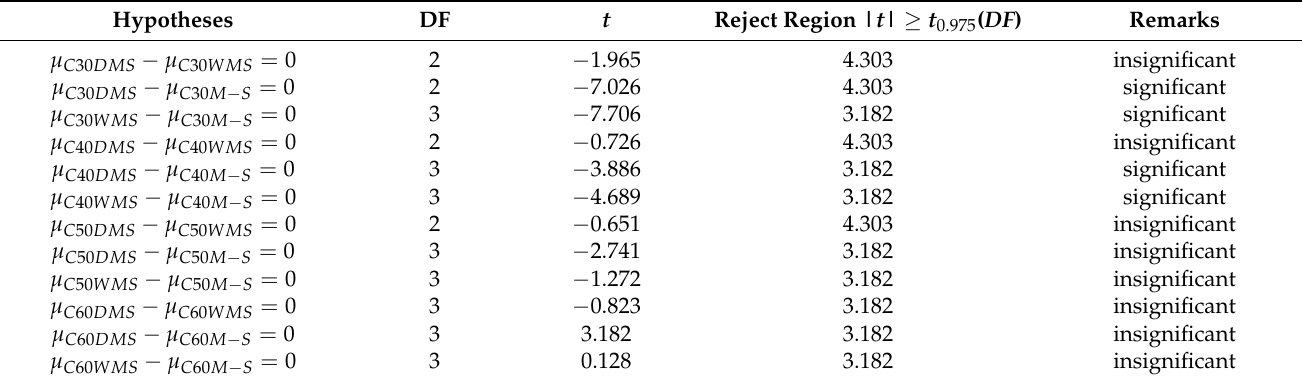
Table 7. Compressive strength of 28-d-aged t -statistical